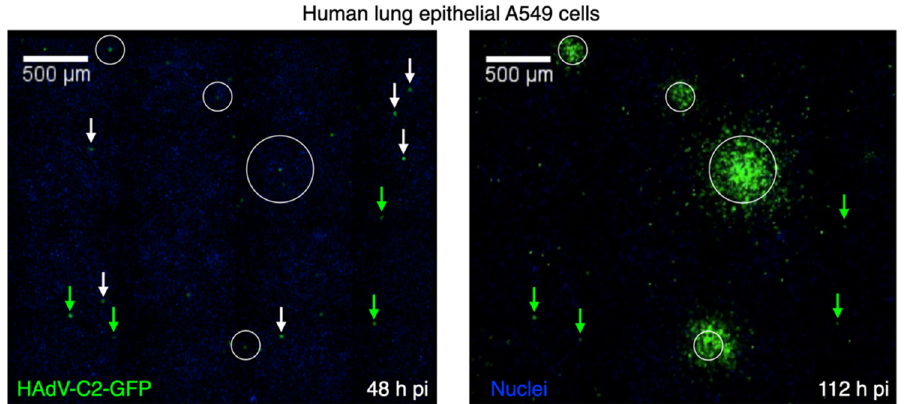
Figure 2. Cell-to-cell variability in plaque formation by HAdV-C2 revealed by single-cell time lapse fluorescence microscopy. Virus-infected cells and infection foci were visualized by EGFP expressed from the viral genome. Live cell plaque assay was conducted under agarose conditions, which restrict convectional spreading of cell-free extracellular virus particles and give rise to round plaque phenotypes, as described in [11]. Circled areas contain plaquing infections, green arrows indicate persistently infected non-plaquing cells, and white arrows indicate infected cells that were eliminated from the dish between 48 and 112 h pi. Nuclei are stained with Hoechst (weak signal in blue). Data from reference [11].